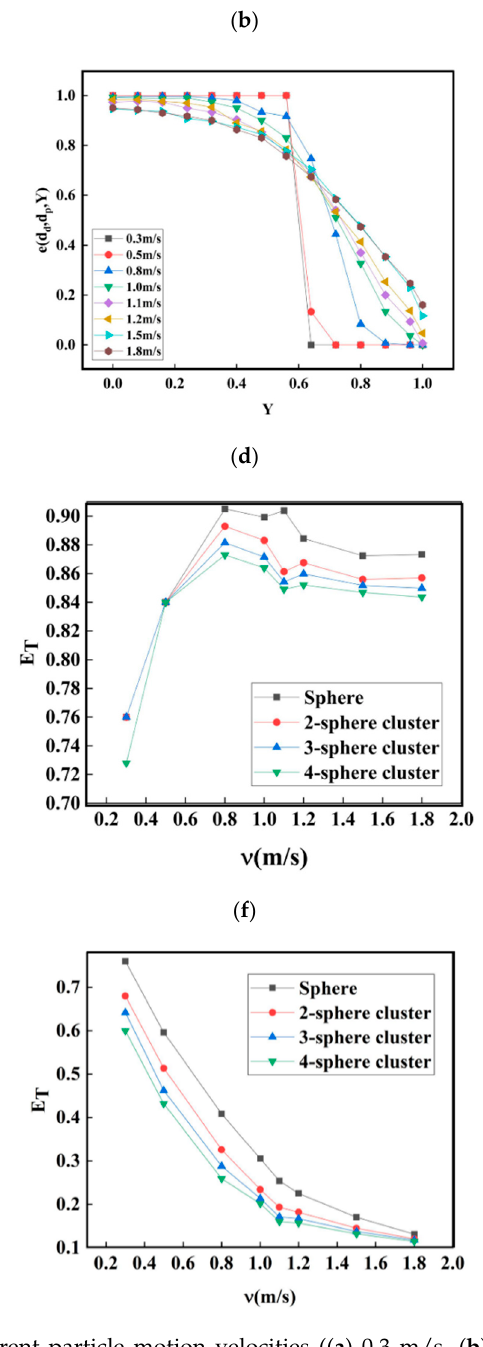
Figure 9. Trapping efficiency for different particle motion velocities (( a ) 0.3 m/s, ( b ) 0.5 m/s, ( c ) 0.8 m/s, ( d ) 1.0 m/s, ( e ) 1.1 m/s, ( f ) 1.2 m/s).